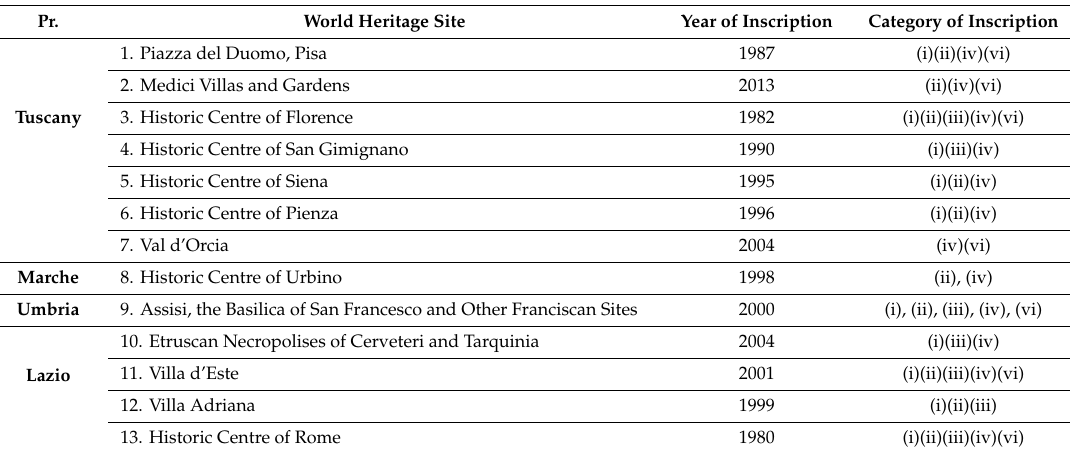
Table 1. World Heritage Sites in Central Italy [43].